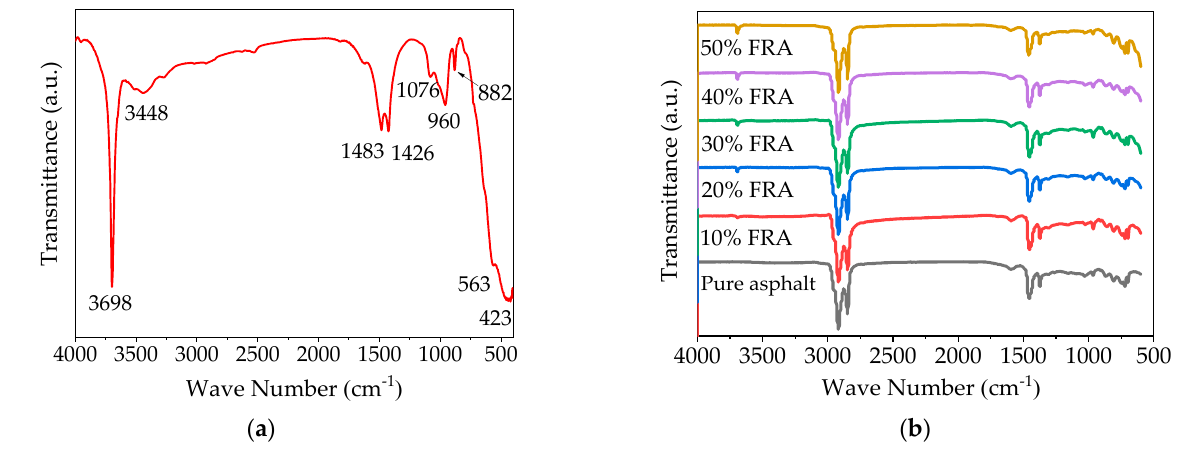
Figure 7. FTIR spectra of FR and FRA: ( a ) FTIR spectra of FR; ( b ) FTIR spectra of FRA. As can be seen in Figure 7b, the functional group region in the FTIR spectrum (4000~1330 cm − 1 ) for FRA had the same characteristic peaks at 2918 cm − 1 , 2850 cm − 1 , 1599 cm − 1 , 1455 cm − 1 , and 1376cm − 1 as the pure asphalt binder and the same characteristic peak at 3698cm − 1 as the FR. The major band at 2918 cm − 1 and 2850 cm − 1 was stretching vibration of CH 2 , the 1599 cm − 1 peak corresponded to C=C phenyl ring skeleton vibration and C=O absorption, the 1455 cm − 1 peak was related to C-H bond’s in-plane stretching vibration, and 1377 cm − 1 peak corresponded to shear vibration of CH 3 bond [62,63]. With an increase